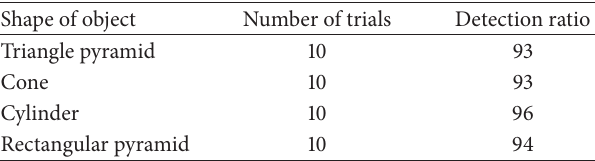
Table 3: Results of shape recognition